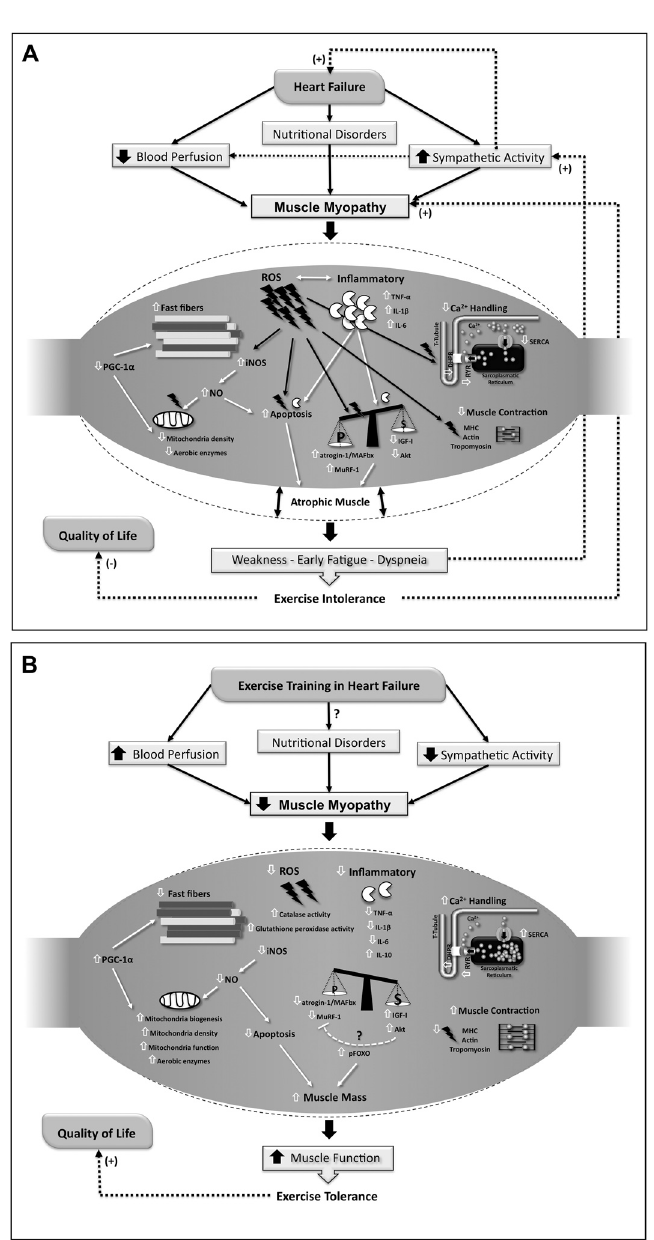
Figure 3. Effect of aerobic exercise training on heart failure-induced skeletal muscle myopathy.